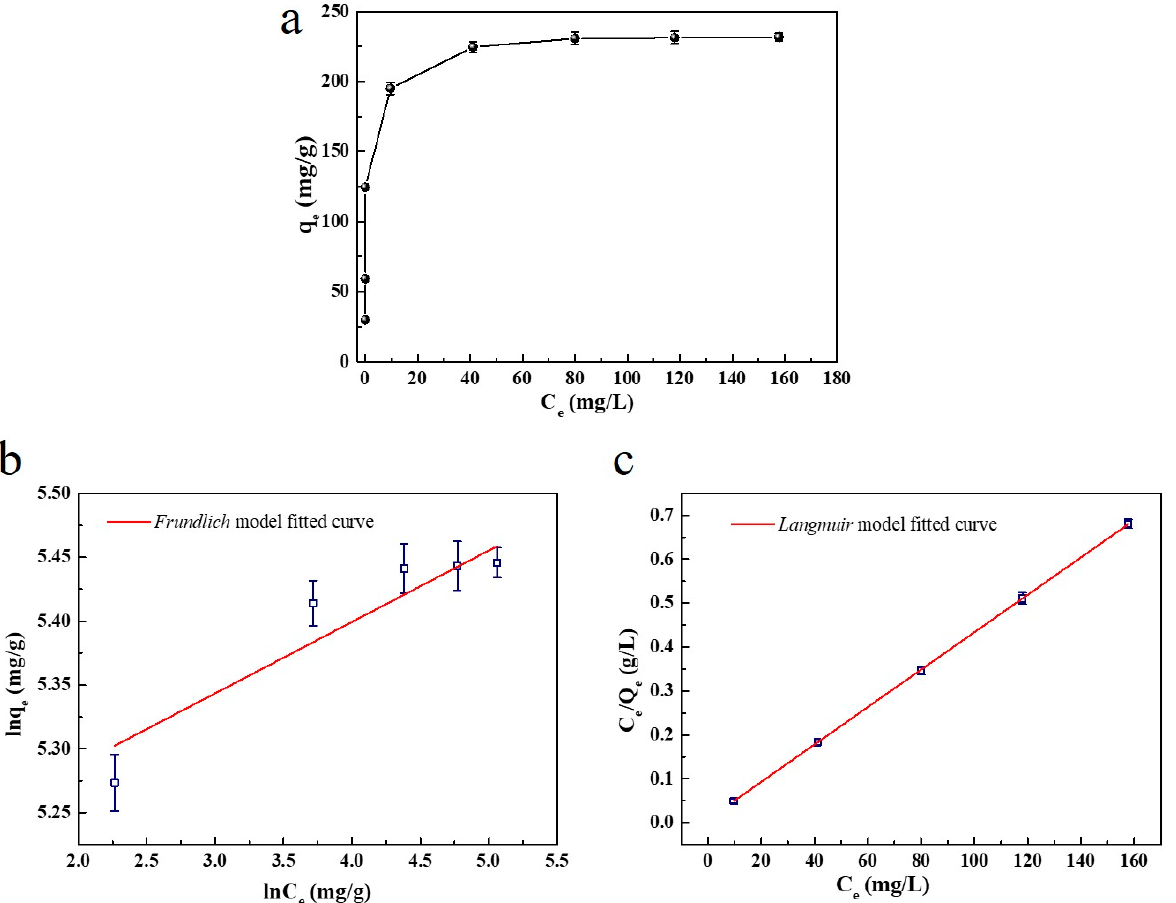
Figure 11. ( a ) Adsorption isotherm, ( b ) Langmuir fitting and ( c ) Frundlich fitting. Table 6. Parameters of adsorption isotherms from Langmuir and Freundlich models. Langmuir Isotherm Model Sample